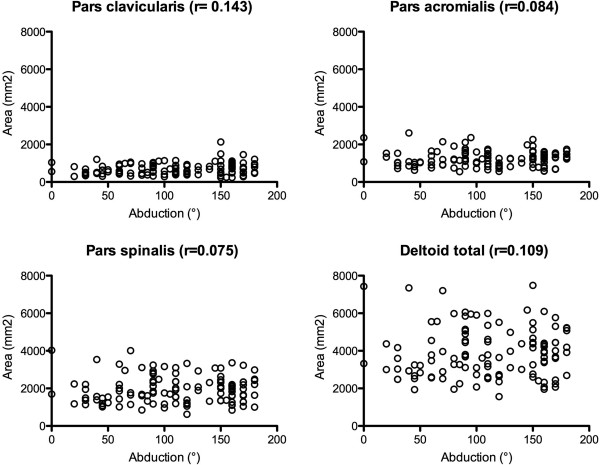
Correlation of the deltoid area.